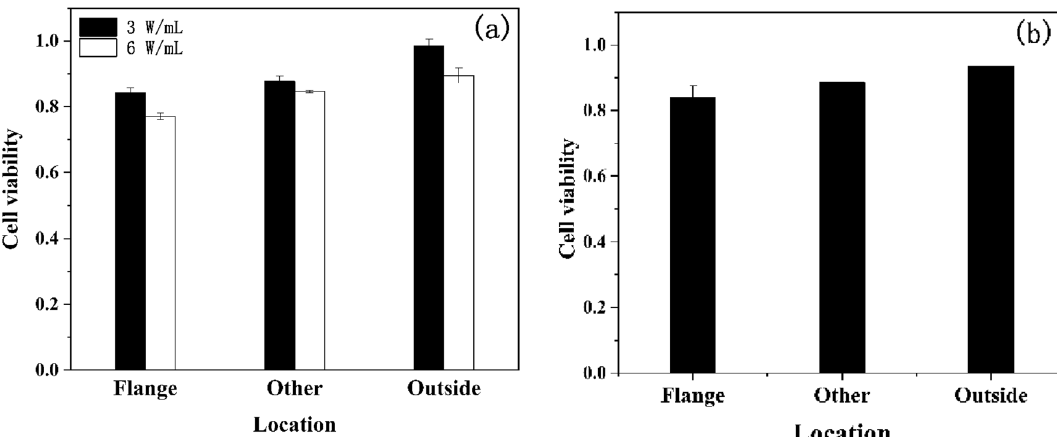
Figure 1. Viability of PC12 cells with a concentration of 3 W/mL and 6 W/mL ( a ) and HaCat cells With a concentration of 6 W/mL ( b ) irradiated by the the "SG-III" prototype laser facility at different locations of the target range (“Flange” represents location near the window of the chamber, “Other” represents location away from the chamber, “Outside” represents location outside the target range, so the radiation dose increased sequentially from Flange to